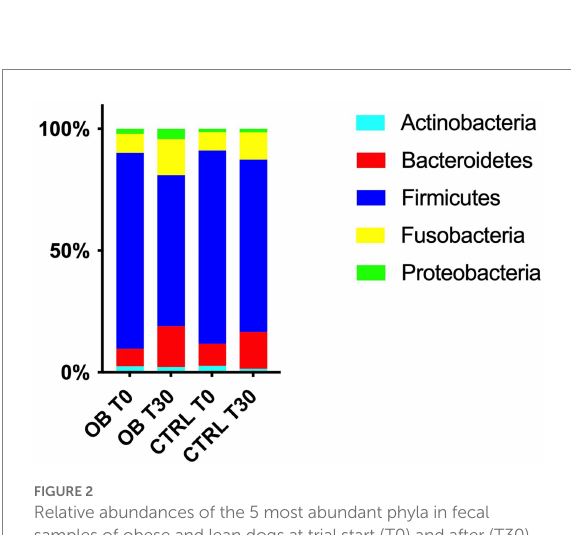
FIGURE 2 Relative abundances of the 5 most abundant phyla in fecal samples of obese and lean dogs at trial start (T0) and after (T30) dietary treatment. In obese dogs, the median abundance of Firmicutes decreased after dietary treatment (T0: 86% vs. T30: 59%, q = 0.010), while a tendency to an increase was observed